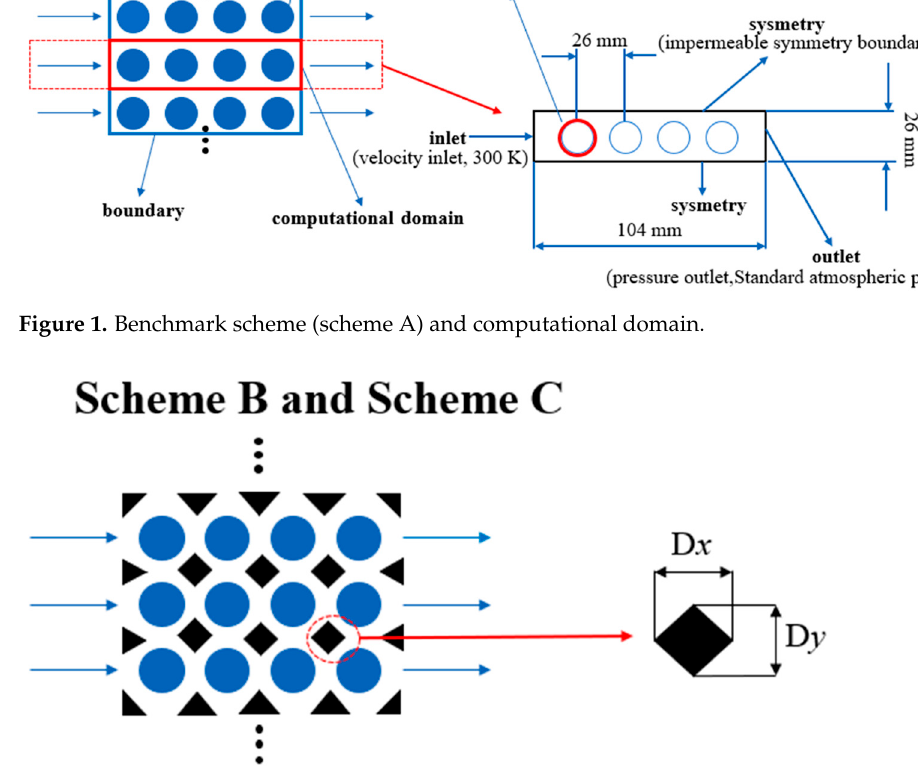
Figure 2. Spoiler prism scheme (schemes B and C).